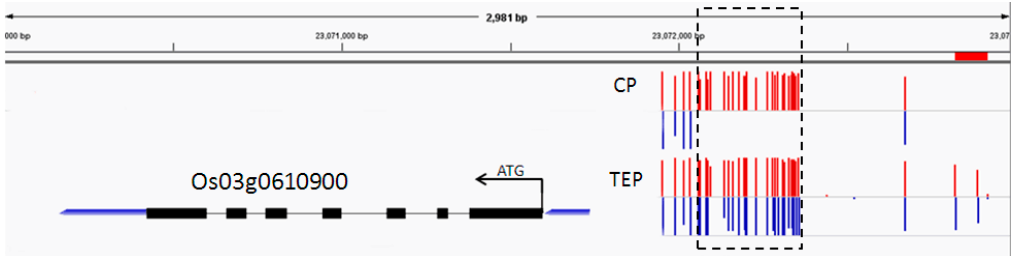
Figure 9 . Homologous evolutionary tree of the ICE-CBF-COR cold stress response signaling pathway. The gene ID with Os is the rice gene, the other is Arabidopsis thaliana gene.